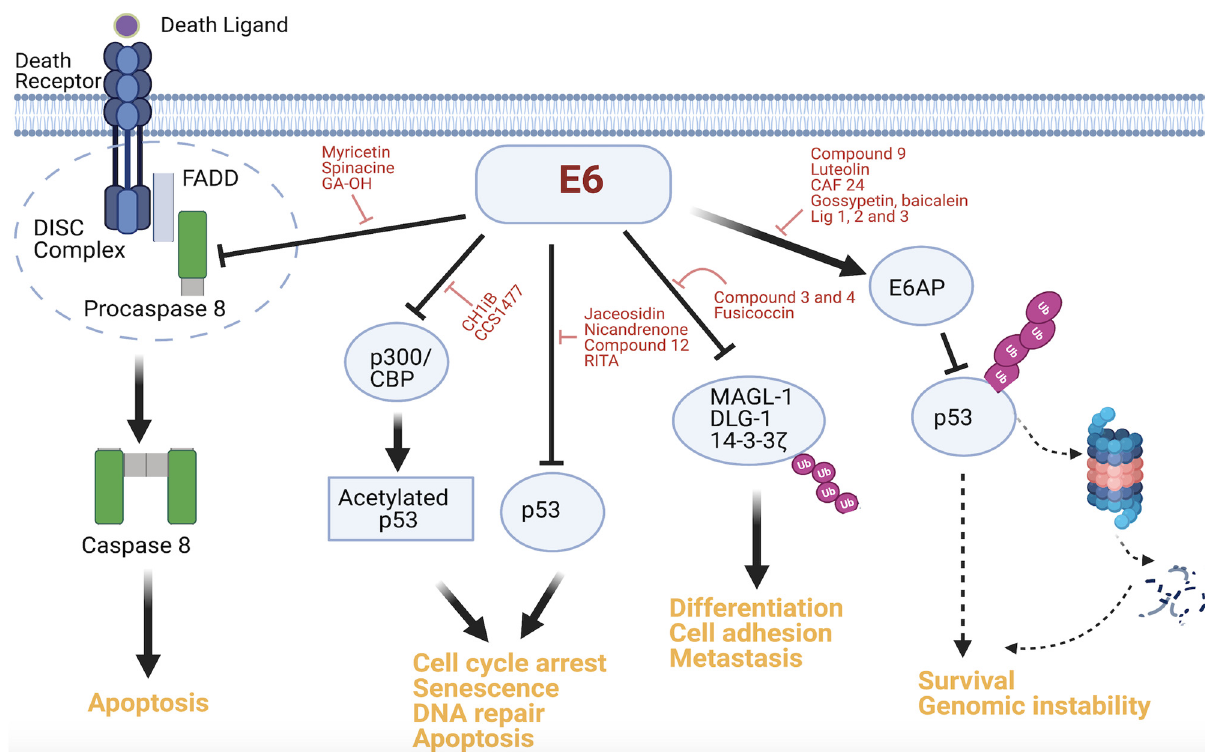
Figure 2. Actionable PPIs of E6. Host protein substrates that interact with E6 and the affected downstream effectors and oncogenic signaling are shown. The small-molecule inhibitors that perturb the binding of E6 to these substrates have been identified and are highlighted. The processes that are impacted by these modulators include apoptosis, cell cycle arrest, differentiation, and metastasis. (Figure created using Biorender).